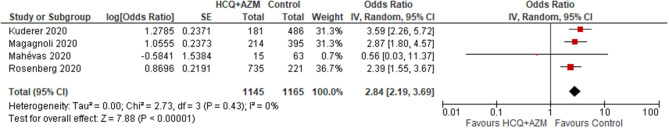
All-cause mortality (HCQ + AZM vs. control; observational studies).